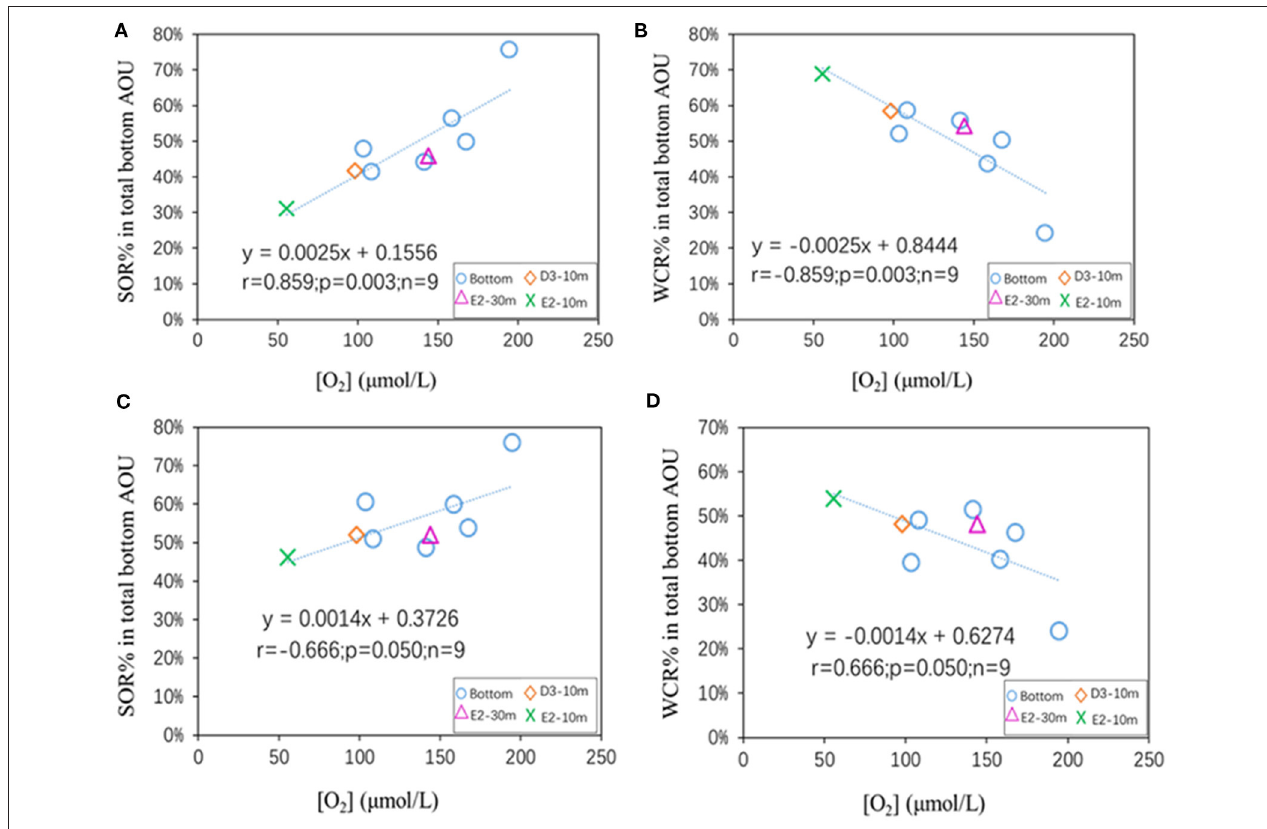
FIGURE 11 | The relationship between [O 2 ] ( µ mol/L) and the SOR% and WCR% contributions to total AOU for all sub-pycnocline samples shallower than 70 m: (A,B) Calculated from the IR model, (C,D) calculated from the AS